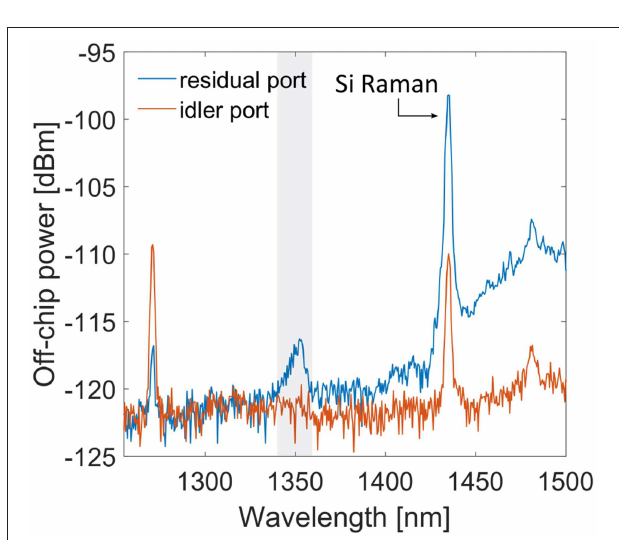
FIGURE 9 | Spectra of the generated idler for the spontaneous FWM with an inter-modal combination 1122TE. The waveguide width used is 6 µ m . The idler spectrum has been measured at the residual (blue) and idler (orange) ports. The peak at 1,434nm is the anti-Stokes Raman from silicon. The broad peak at 1,475nm is the anti-Stokes Raman due to the silica input fiber. The gray boxes highlight the spurious